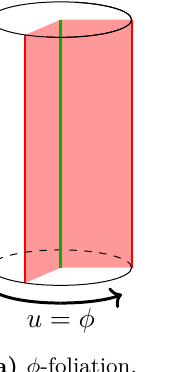
Figure 12. Two ADM foliations of conical AdS 3 (3.14). In (a), we take the foliation coordinate u to be φ , which is periodic. Additionally, the u -cycle shrinks to 0 at r = 0 , which is a horizon that acts as a boundary for each Cauchy slice Σ . In (b), we take the foliation coordinate to be τ and we may make it periodic (resulting in a decomposition of the torus into disks). For this foliation, the slices do not contain horizons acting as boundaries in the bulk, and the conical line defect runs orthogonally to the slices. These are the decompositions relevant to our particular